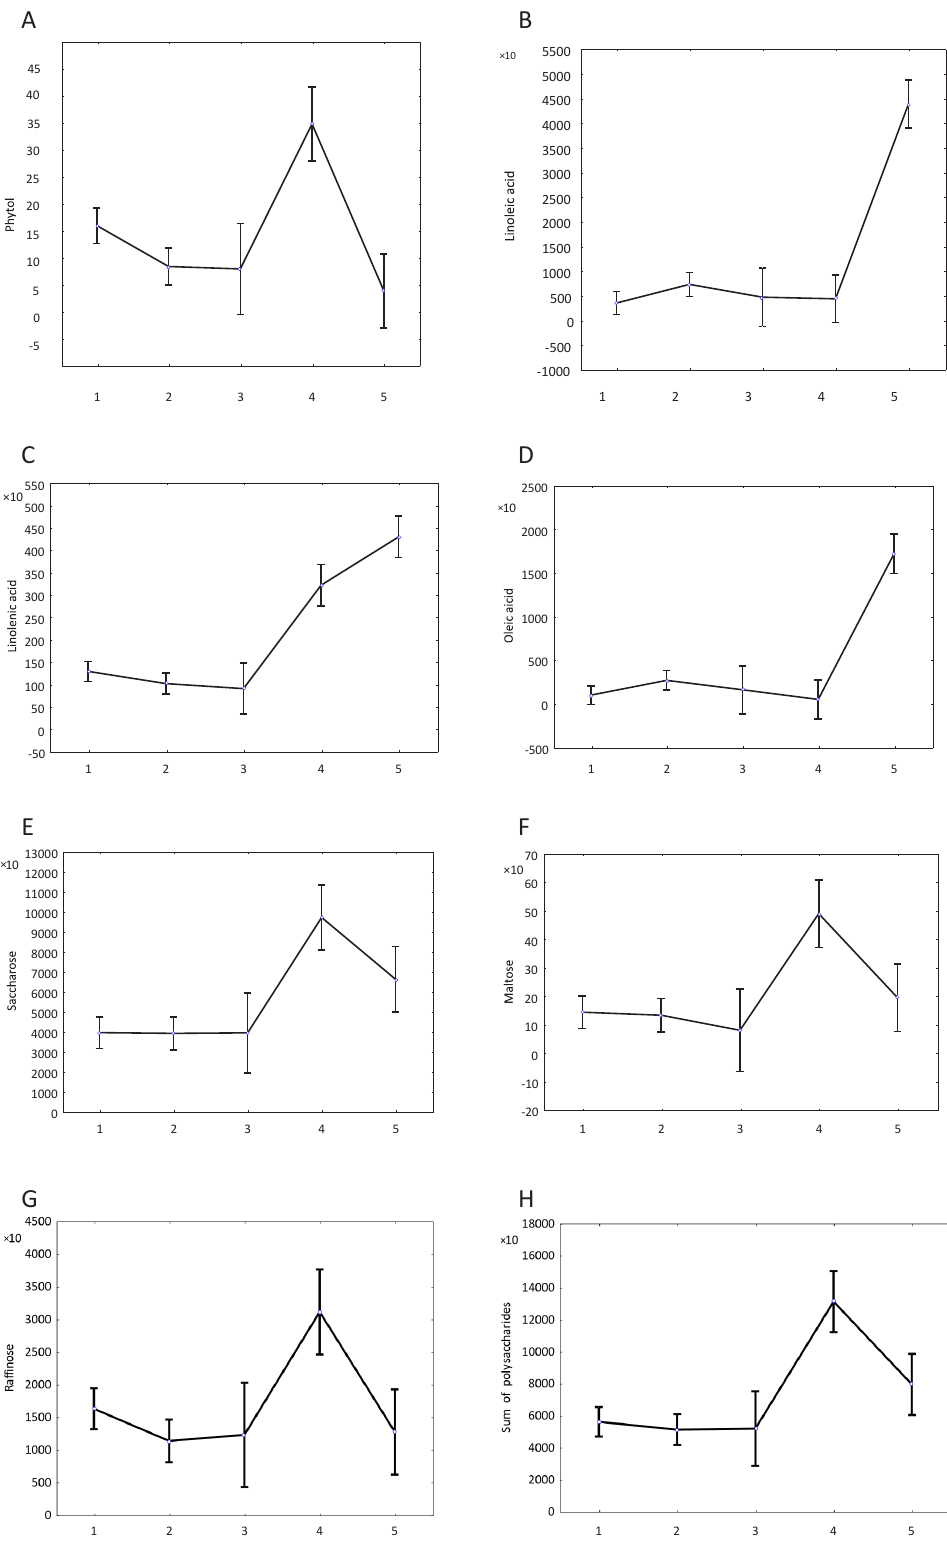
Fig. 1. Amounts of phytol, polyunsaturated fatty acids, and polysaccharides (ppm in dry matter) in hemp seeds ( Cannabis spp.) from different groups of accessions. (A) Phytol; (B) Linoleic acid; (C) Linolenic acid; (D) Oleic acid; (Е) Sucrose; (F) Maltose; (G) Raffinose; (H) Total polysaccharides. Accession designations along X-axis: (1) Feral; (2) Dual use (fibre and seed); (3) Universal (fibre, oil and seed); (4) Recreational landraces; (5) Food seed and oil (minimized seed coat/pericarp). Means, vertical bars denote 0.95 confidence intervals. NW of Russia,